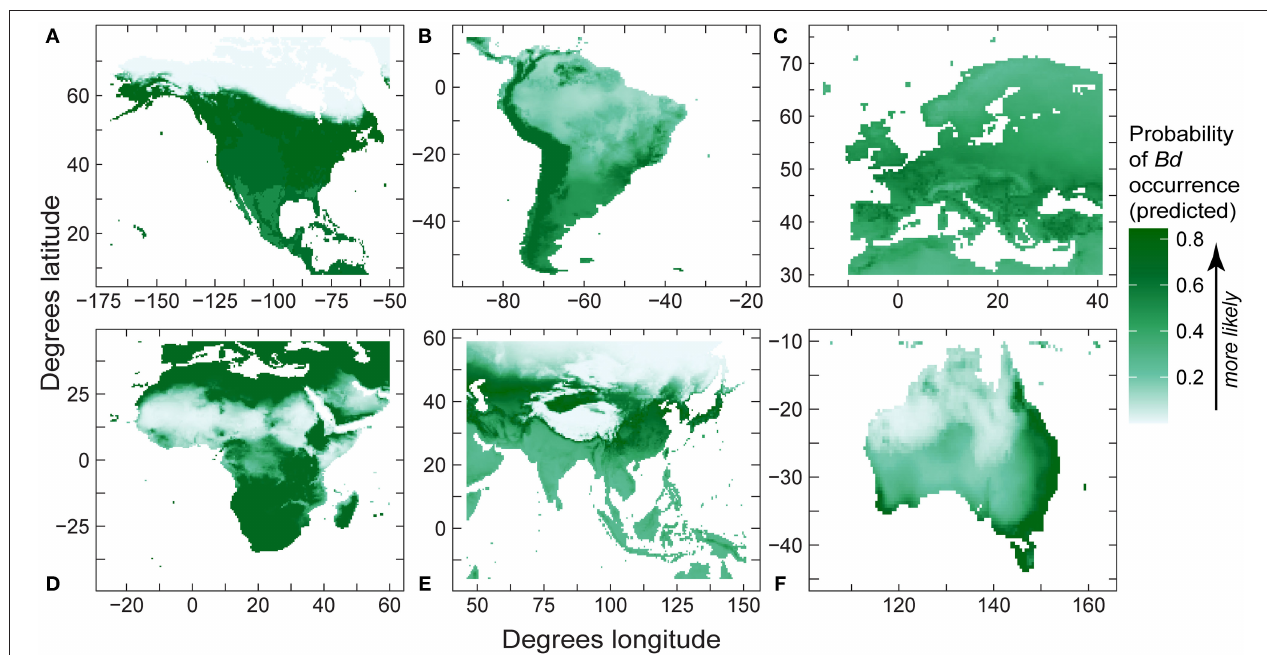
FIGURE 8 | Regional predictions of Batrachochytrium dendrobatidis ( Bd ) absolute probability of Bd occurrence from our best-fit presence-absence species distribution models (area under curve values in Table 6 ) using Bd data compiled through December 2019 for: (A) North America; (B) South America; (C) Europe; (D) Africa; (E) eastern Asia; and (F)